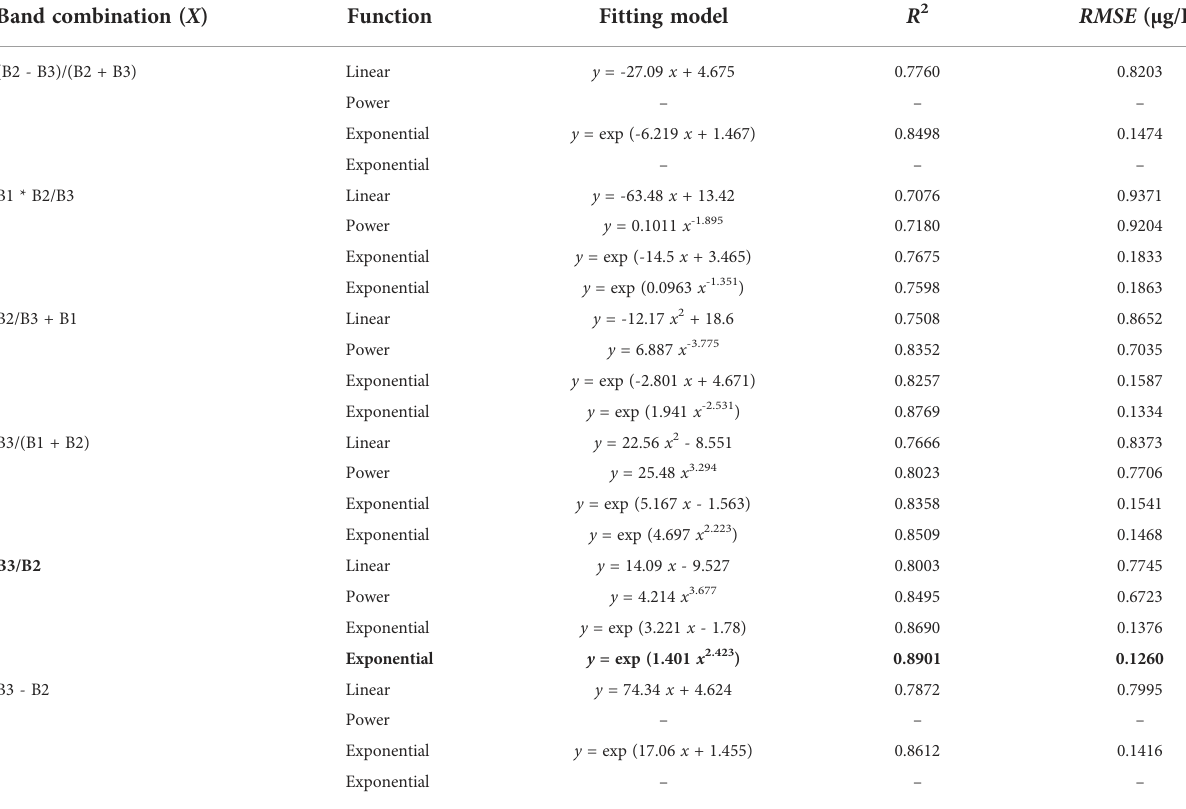
TABLE 6 Band combination inversion model of Chl- a